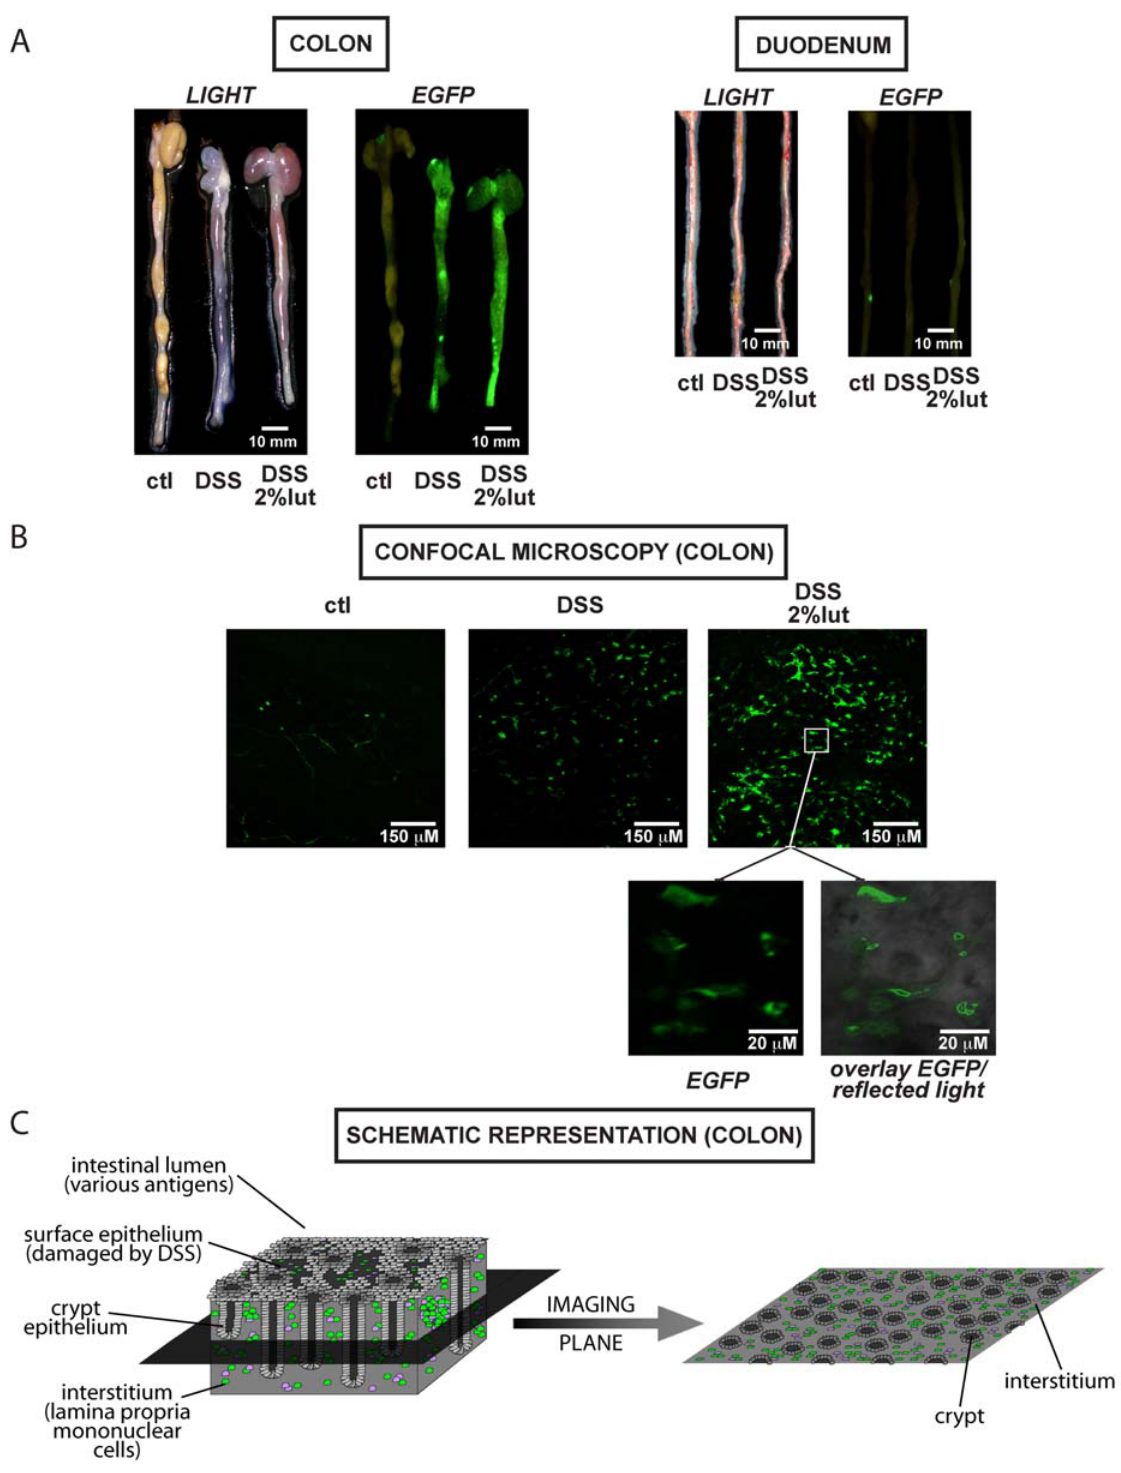
Figure 2. Enhanced EGFP expression in luteolin fed, DSS exposed NF- k B EGFP mice as compared to control diet is confined to lamina propria mononuclear cells. NF- k B EGFP mice (n=7 per group) were sacrificed after 6 days of 3% DSS exposure, and dissected colon (left panel) and duodenum/proximal jejunum (right panel) were imaged at this time for EGFP using the Lightools Research macroimaging system with a dual output lighting (right). Photomicrographs (Nikon cool-pix digital camera) are shown on the left. Representative images are shown (A). Confocal imaging of colonic sections from NF- k B EGFP mice (n=3 per group) after 6 days of 3% DSS exposure was performed immediately after dissection as described in the Methods. Representative results are shown (B). A schematic representation of the colon indicates the plane depicted in the confocal microscopic images. Importantly, EGFP accumulation (NF- k B activation) is predominantly seen in lamina propria mononuclear cells located in between the crypts (LPMNC, light purple and green), and not in surface and crypt epithelium, which is damaged by DSS (light grey) (C).